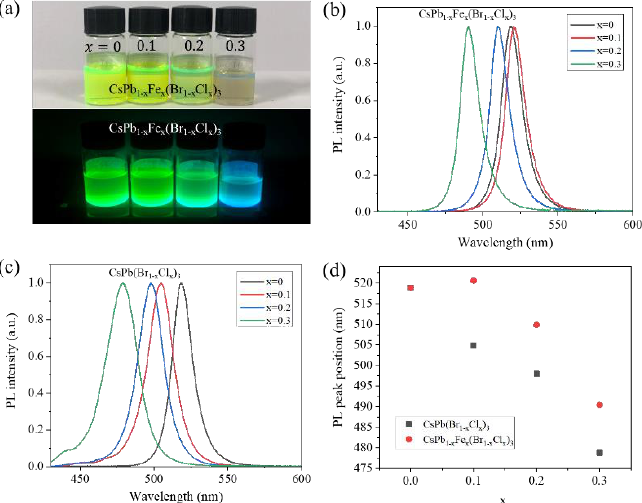
Figure 3. ( a ) Photographs of CsPb 1 − x Fe x (Br 1 − x Clx) 3 NC solutions under natural light (top) and UV light (bottom). ( b ) Normalized PL spectra of CsPb 1 − x Fe x (Br 1 − x Cl x ) 3 NC solutions. ( c ) Normalized PL spectra of CsPb(Br 1 − x Cl x ) 3 NC solutions. ( d ) Comparison of PL peak positions of CsPb 1 − x Fe x (Br 1 − x Cl x ) 3 and CsPb(Br 1 − x Cl x ) 3 NC solutions at different x (x = 0, 0.1, 0.2, 0.3). The excitation wavelength kept as 405 nm.